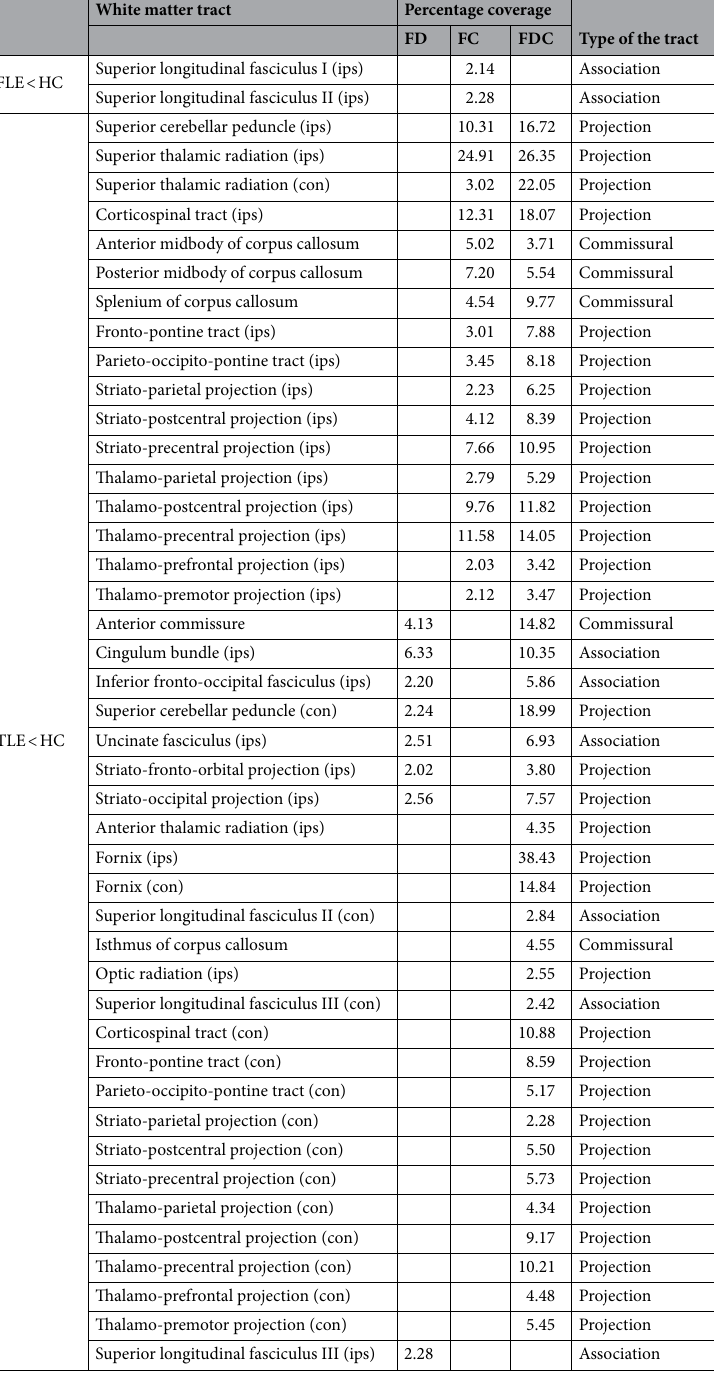
Table 2. Overview of a group statistical analyses that led to significant results. HC, healthy control subjects; FD, fibre density; FC, fibre cross-section; FDC, fibre density and cross-section; ips, ipsilaterally to resection; con, contralaterally to